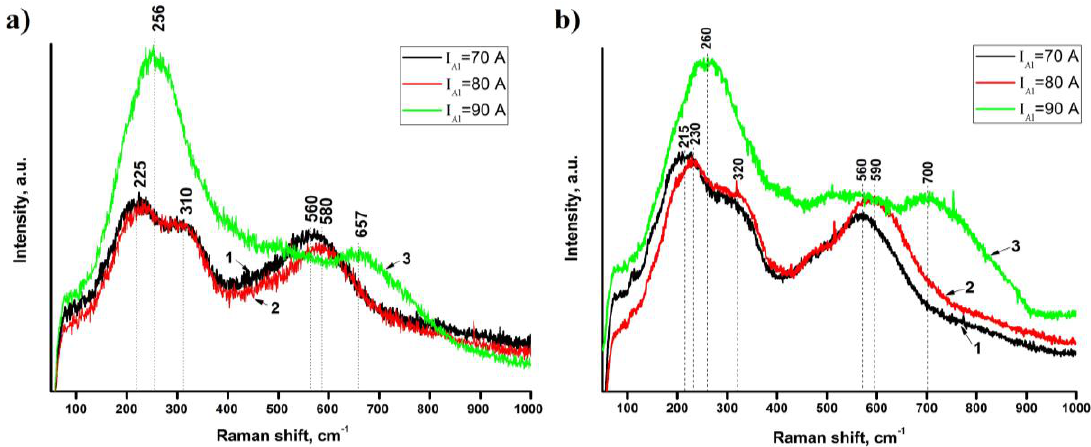
Figure 8. Raman spectra of deposited Ti-Al-N coatings obtained on the surface ( a ) and inside the wear track b ).